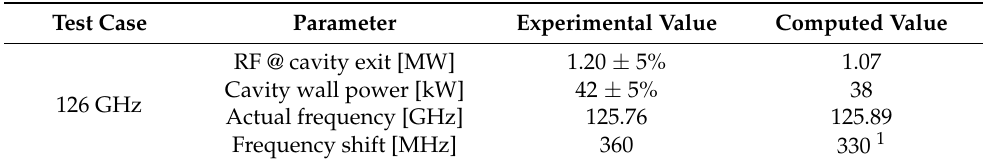
Table 1. Summary of the main results of the validation of the cavity simulator against the